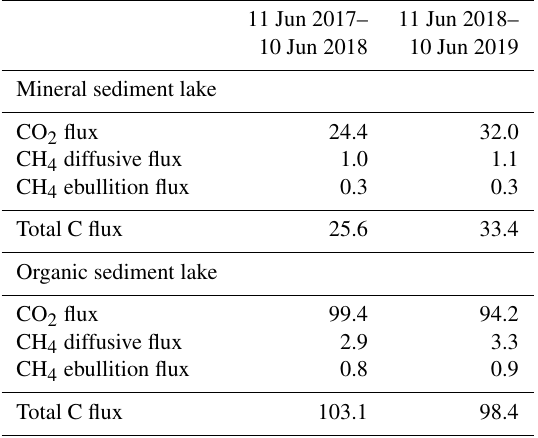
Table 6. Modelled annual CO 2 and CH 4 balances (gCm − 2 ) of the MS and OS lakes during the 2 study years (Kou et al.,